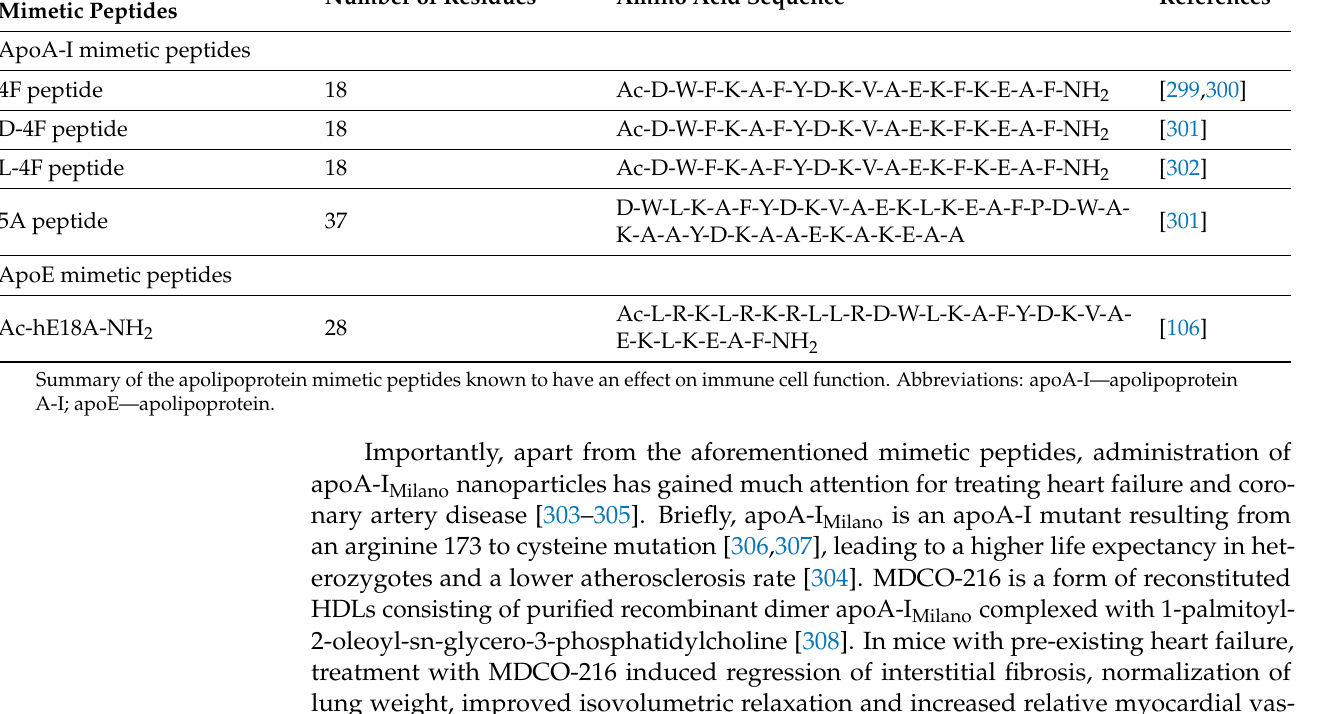
Table 6. Summary of apolipoprotein mimetic peptides known to have an effect on immune cell function. Specific